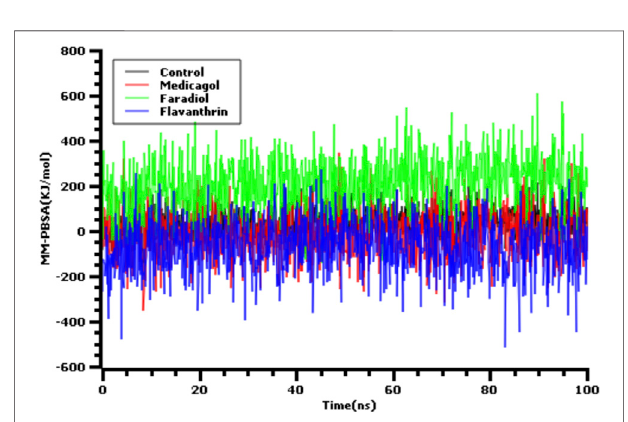
FIGURE 4 | The binding free energy of the control and top three phytochemical compounds where more positive score indicates more better